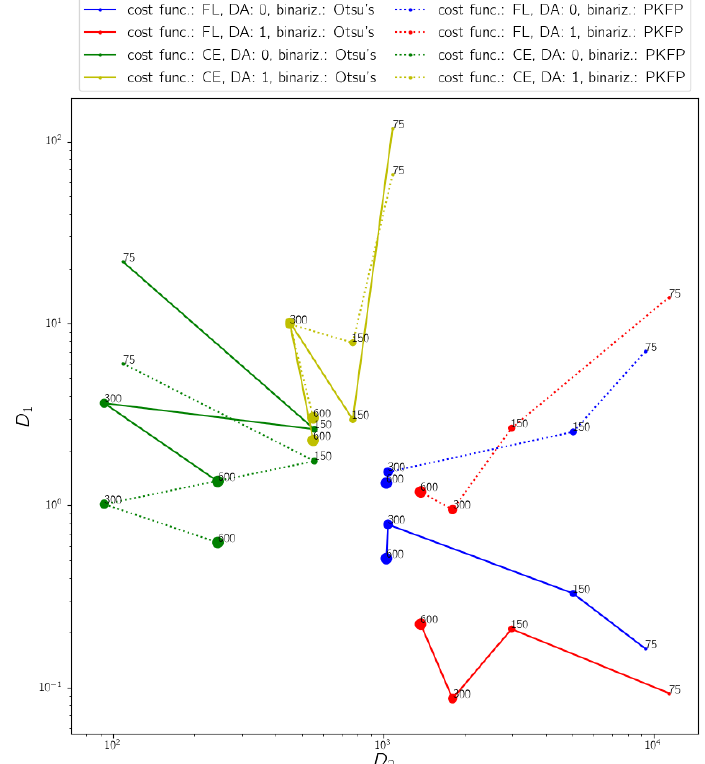
Figure 6. Graphical representation of the results in terms of D 1 and D 2 for each of the 16 models in Table 1. Each color corresponds to each of the four tested configurations. Blue: FL, DA = 0; Red: FL, DA = 1; Green: CE, DA = 0; Yellow: CE, DA = 1. Marker size refers to the number of images used to train each model (from 75 to 600). Continuous line D 1 values were computed using Otsu’s method, whereas discontinuous lines were obtained using PKFP